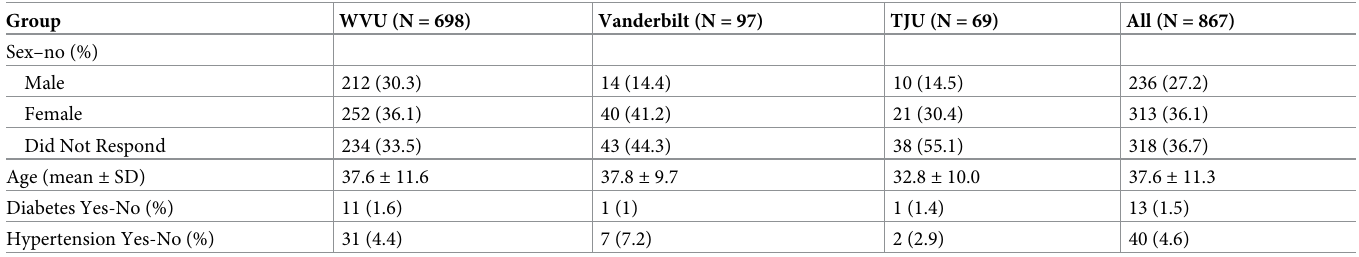
Table 2. Study populations